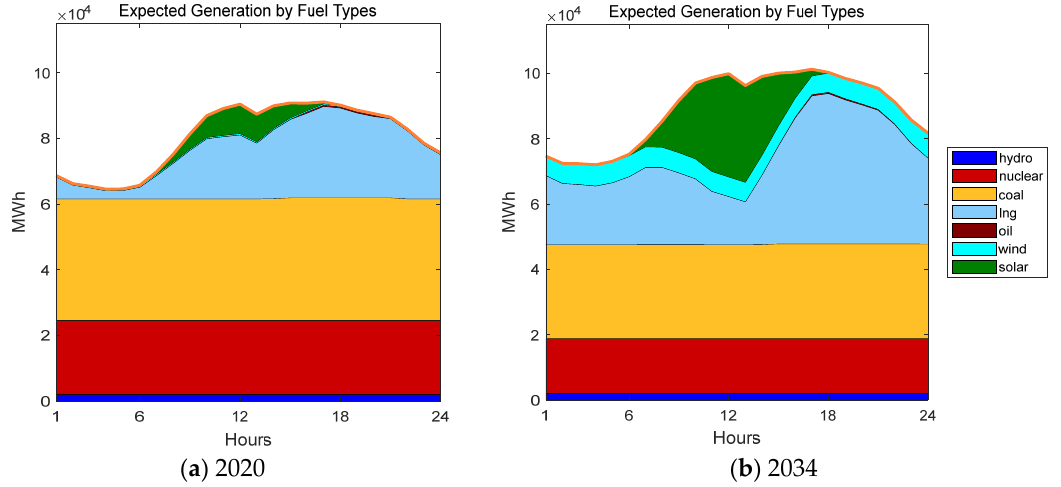
Figure 4. Expected generation profiles by fuel type, 2020 vs. 2034.